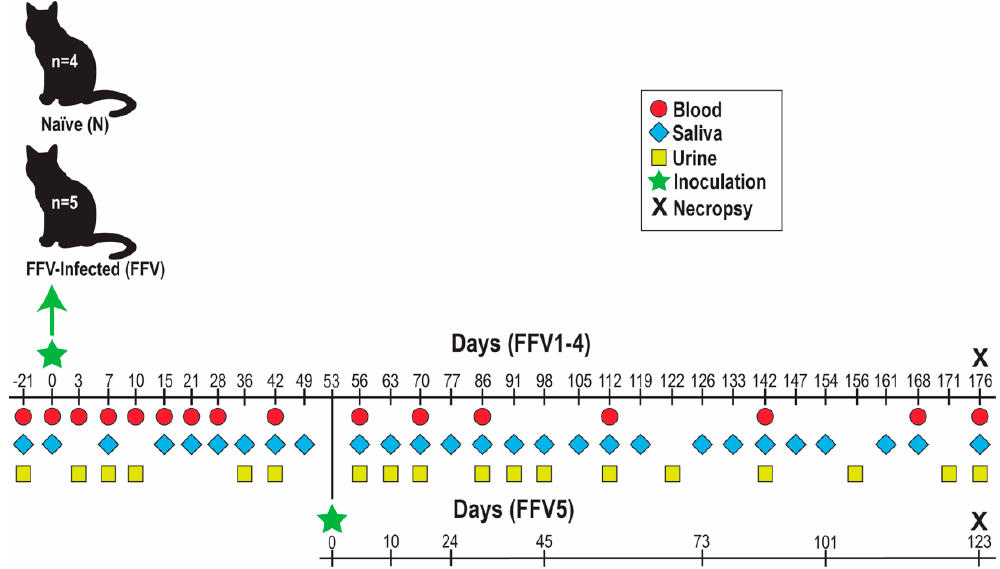
Figure 1. Experimental timeline of feline foamy virus (FFV) (strain pCF-7) inoculation and sample collection in specific-pathogen-free (SPF) domestic cats. Cats were separated into groups based on inoculum type: negative Crandell feline kidney (CrFK) culture media (naïve control cats N1-4) or FFV in CrFK cell culture supernatant (cats FFV1-5). Blood, saliva, urine, and tissues were collected on the dates specified. Sample collection for cat FFV5 was on a different schedule than the rest of the cohort (bottom timeline, adjusted to match rest of FFV cohort). Samples for baseline data were collected on day -21. On day 176 post-inoculation, cats were euthanized to perform necropsy and tissue collection (black X ). Figure modified with permission from [10].